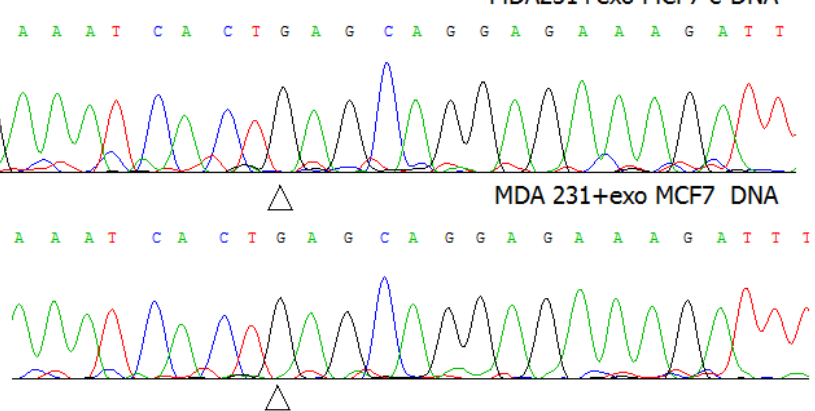
Figure 3. The sequence electrophoregrams of DNA and c-DNA of MDA-MB-231 cells after treatment with the exosomes of MCF7 cells.